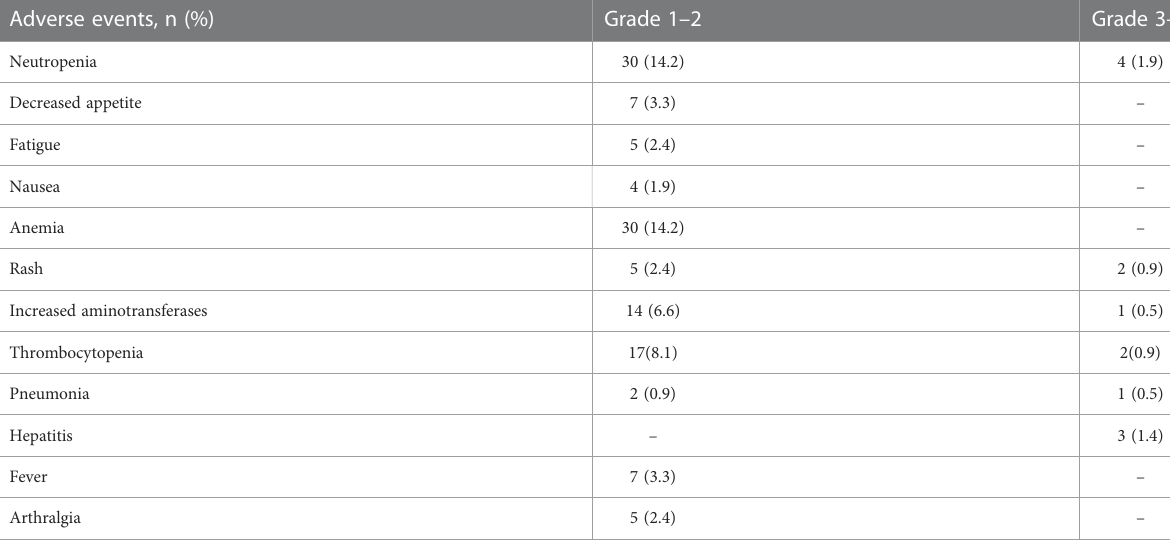
TABLE 3 Treatment-related adverse events during neoadjuvant immunotherapy plus chemotherapy.